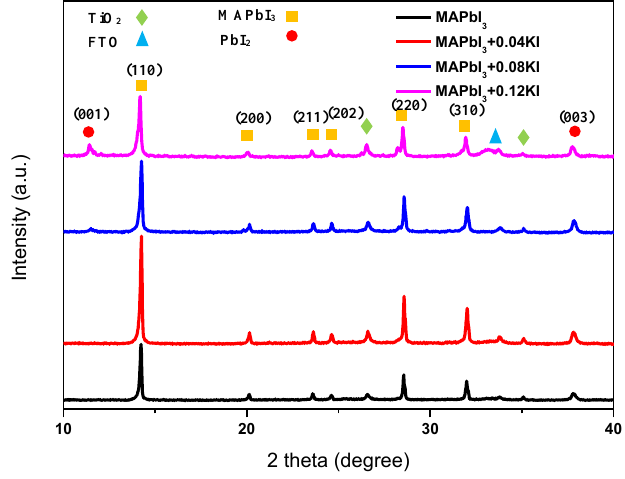
Figure 3. XRD pattern of perovskite films with different K + concentrations.